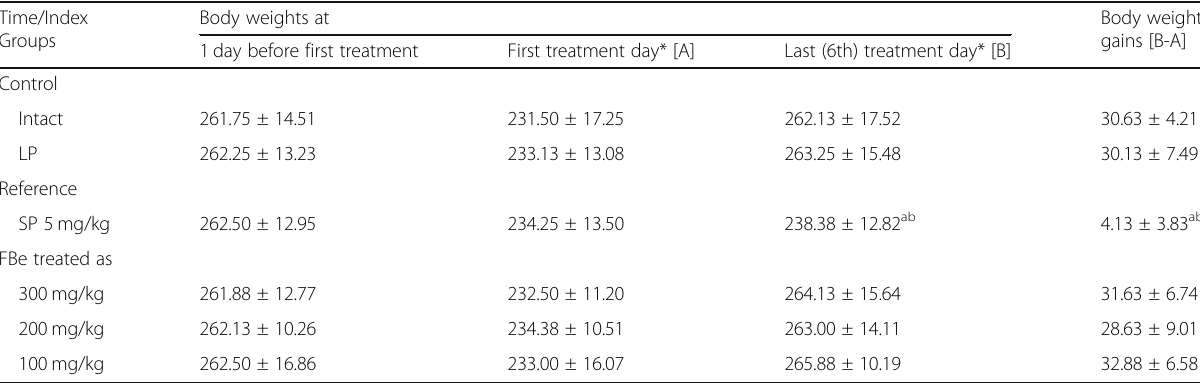
Table 2 Body weight gains in the constipation rats induced by LP Time/Index Groups